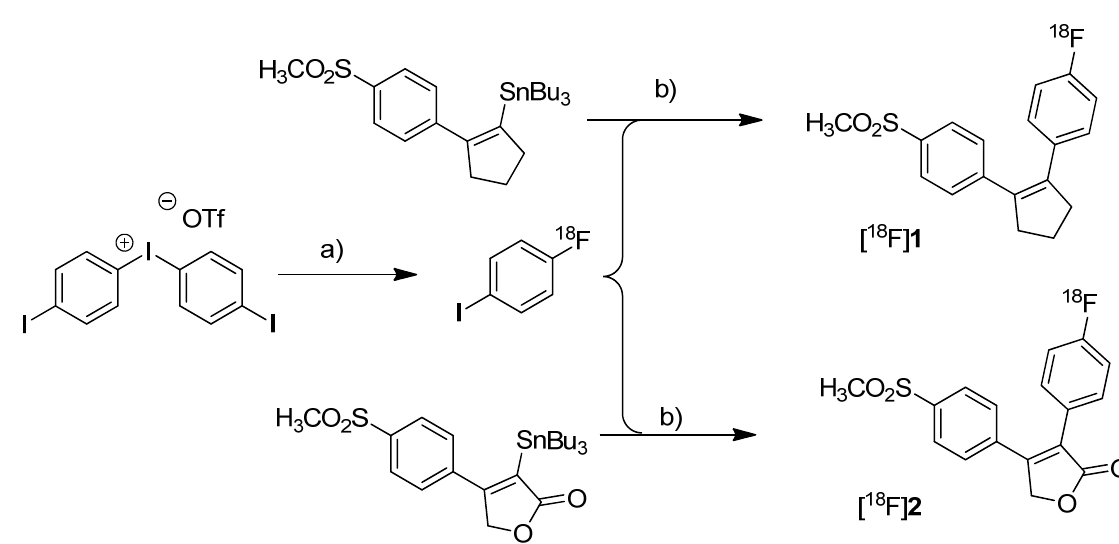
Scheme 1. Synthesis of [ 18 F] 1 and [ 18 F] 2